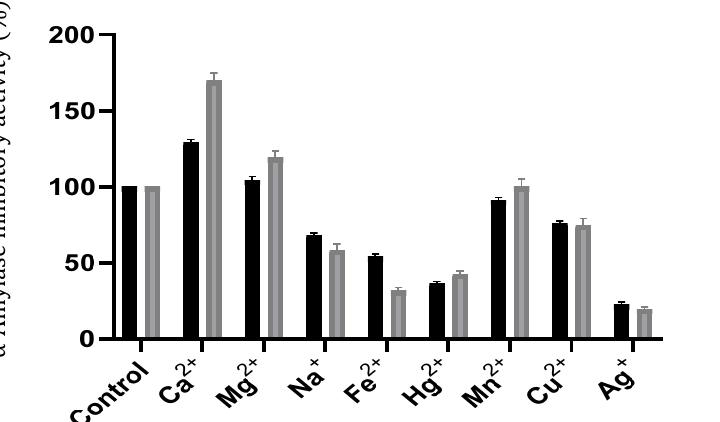
Figure 4. Effects of metal ions at concentrations of 1 and 5 mM on α AI.Mol activity. The α -amylase inhibitor assay was performed at 45 °C and pH 8. The control represents 100% of the α -amylase inhibitor activity under the same condition in the absence of any metal. Data shown are mean ± SD ( n = 3).